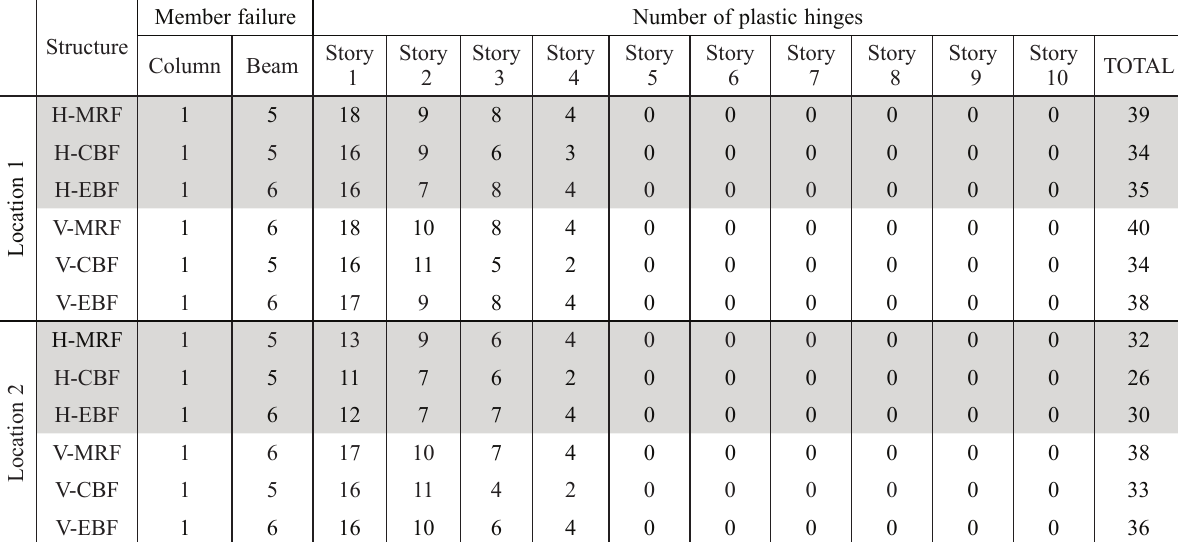
Table 8. Plastic hinge and member failure for irregular MRF, EBF, and CBF Structure